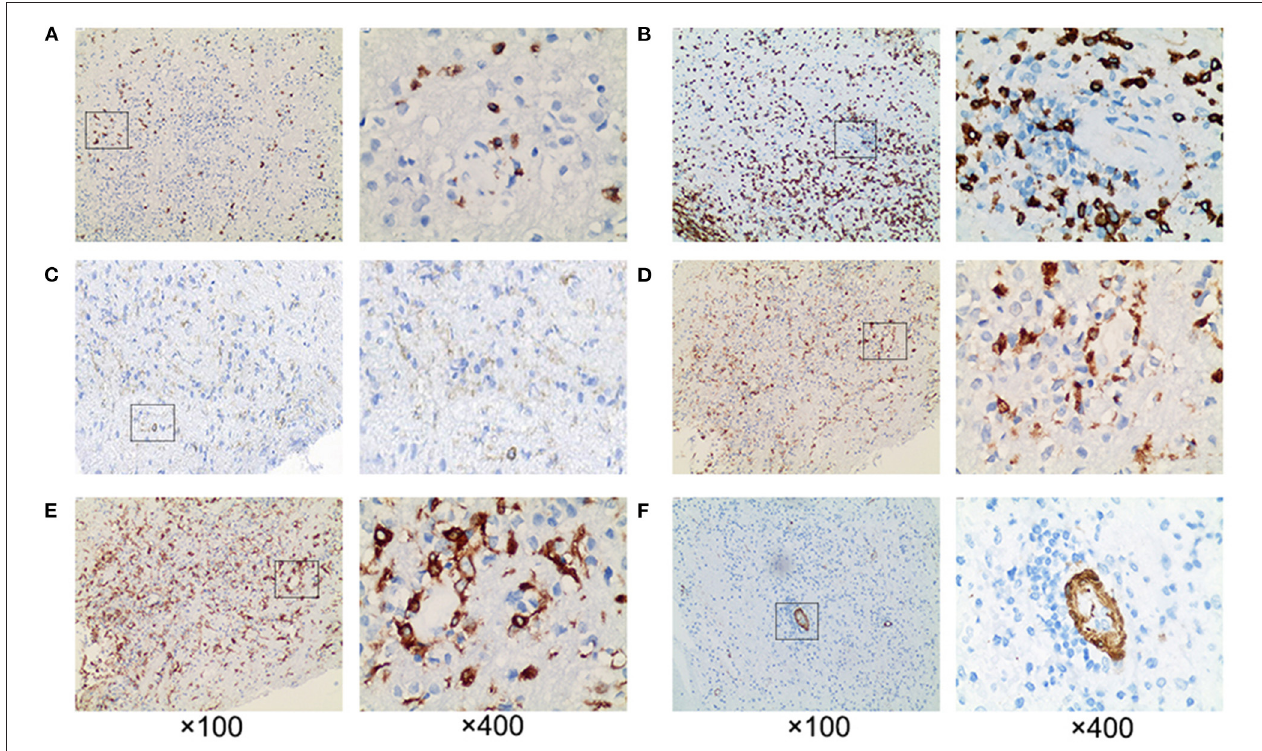
FIGURE 4 | Pathological examination revealed extensive perivascular inflammation. (A) CD8 + T cells and (B) CD3 + T cells were infiltrated throughout the brain parenchyma, rather than (C) CD4 + T cells. Prominent perivascular cuffing of (D) CD68 + and (E) CD163 + macrophages were seen scattered around small vessels and in the parenchyma. (F) The vessel wall indicated by SMA was intact. × 100 and ×